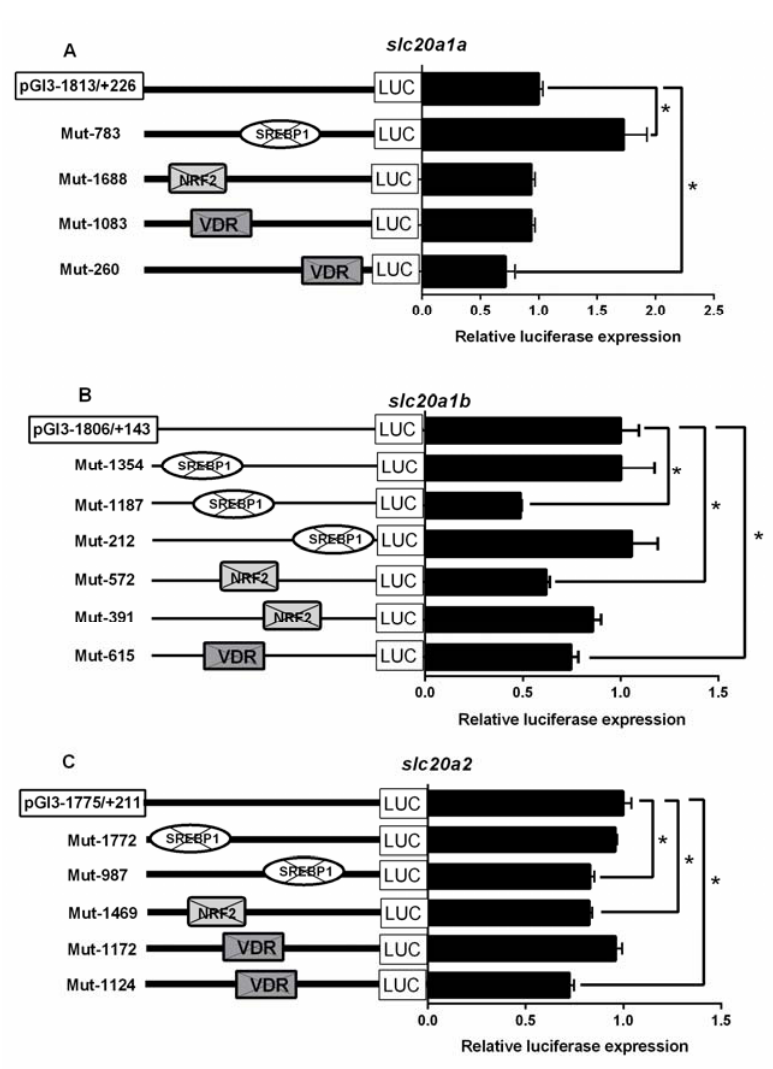
Figure 3. Analysis of putative transcript factor binding sites by site-directed mutagenesis. ( A ) Mutations of slc20a1a promoter at − 783 / − 771, − 1688 / − 1679, − 1083 / − 1076, and − 260 / − 253 sites; ( B ) Mutations of slc20a1b promoter at − 1354 / − 1345, − 1187 / − 1178, − 212 / − 203, − 572 / − 561, − 391 / 380, and − 615 / − 609 sites; ( C ) Mutations of slc20a1b promoter at − 1772 / − 1763, − 987 / − 977, − 1469 / − 1459, − 1172 / − 1165, and − 1124 / − 1117 sites; values represent the ratio between firefly and Renilla luciferase activities. Results are expressed as the mean ± SEM arbitrary units of three independent experiments. Student’s t-test was undertaken to detect the di ff erences between two groups. Symbol (*) indicates significant di ff erences between the two groups.